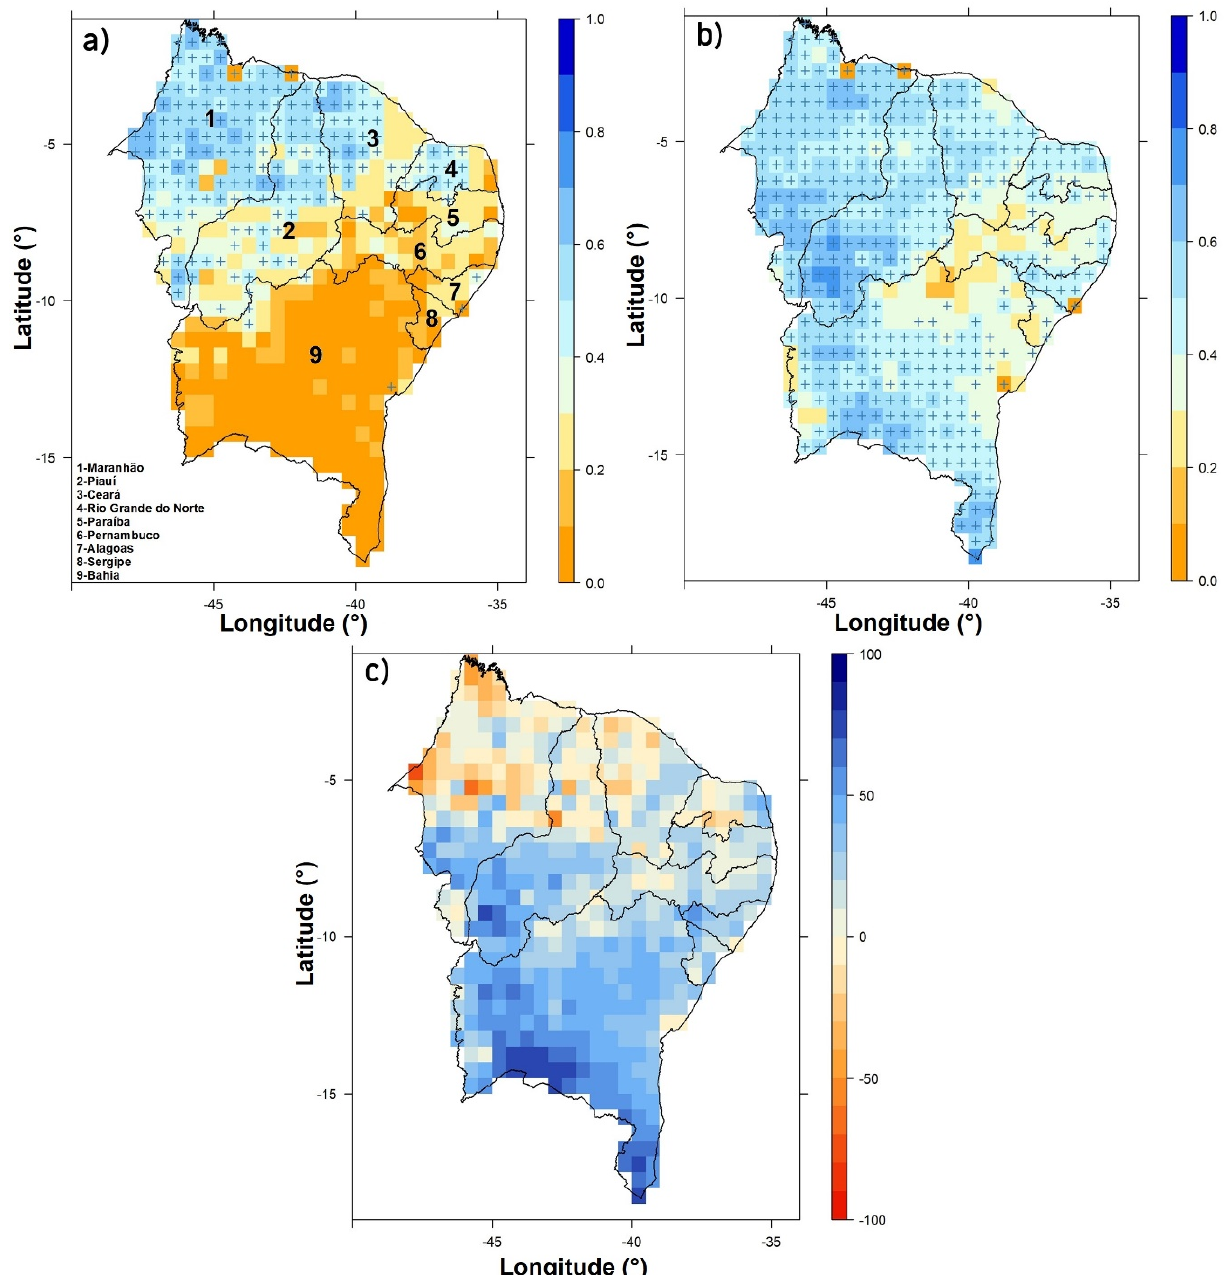
Figure 7. Spatial correlation of the observed time series with the NMME ( a ) and with the EmpM ( b ), as well as the skill correlation score (SCS) of the EmpM against the NMME ( c ). The points on the map represent statistical significance at the 5% level using the student’s t-test.